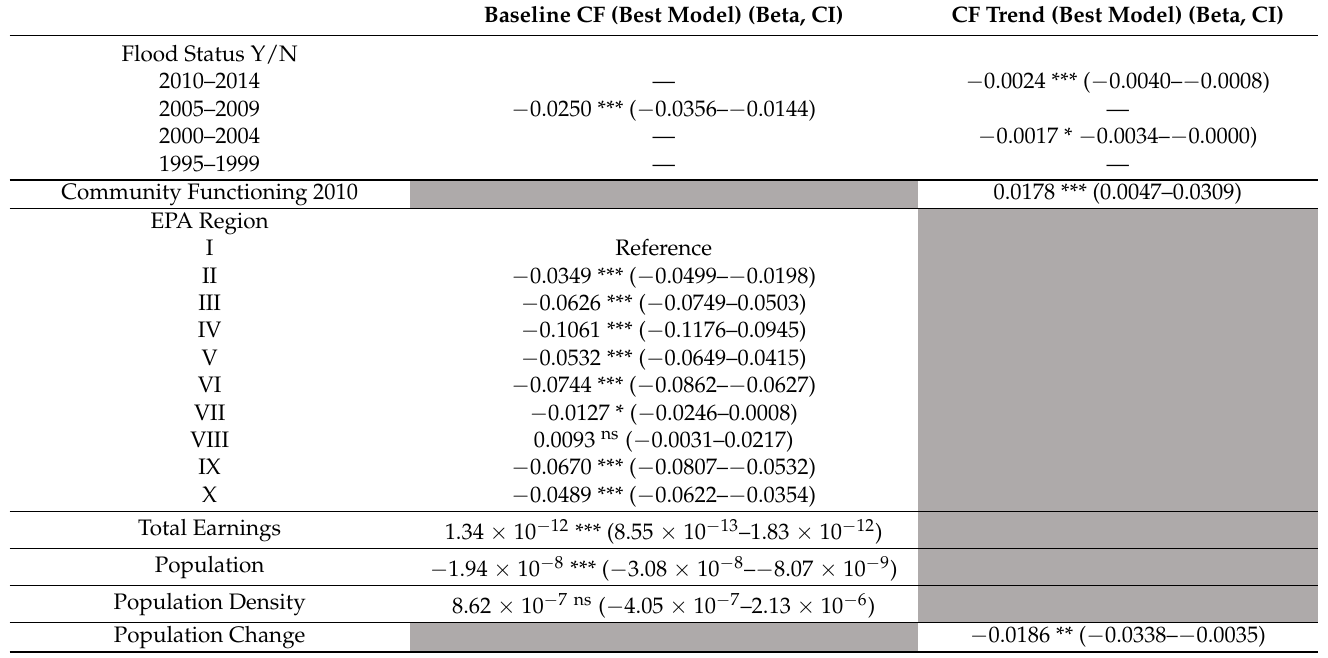
Table 5. Multivariate model of Baseline CF (2010) and CF Trend